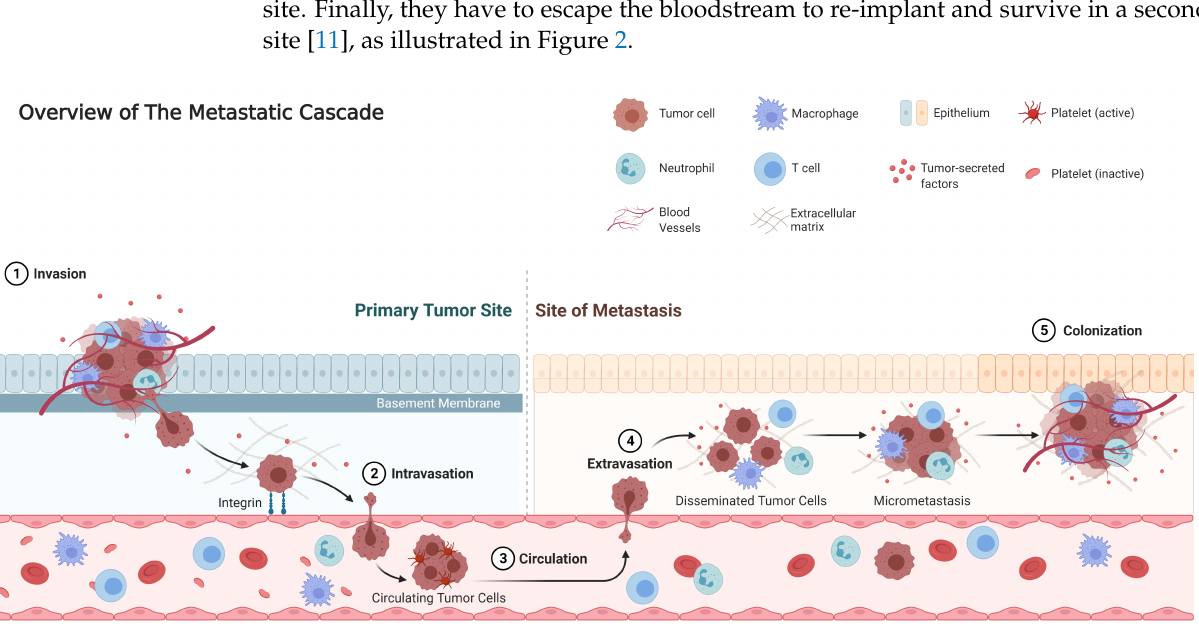
Figure 2. Overview of the steps in cancer metastasis. (Adapted from Fares et al.